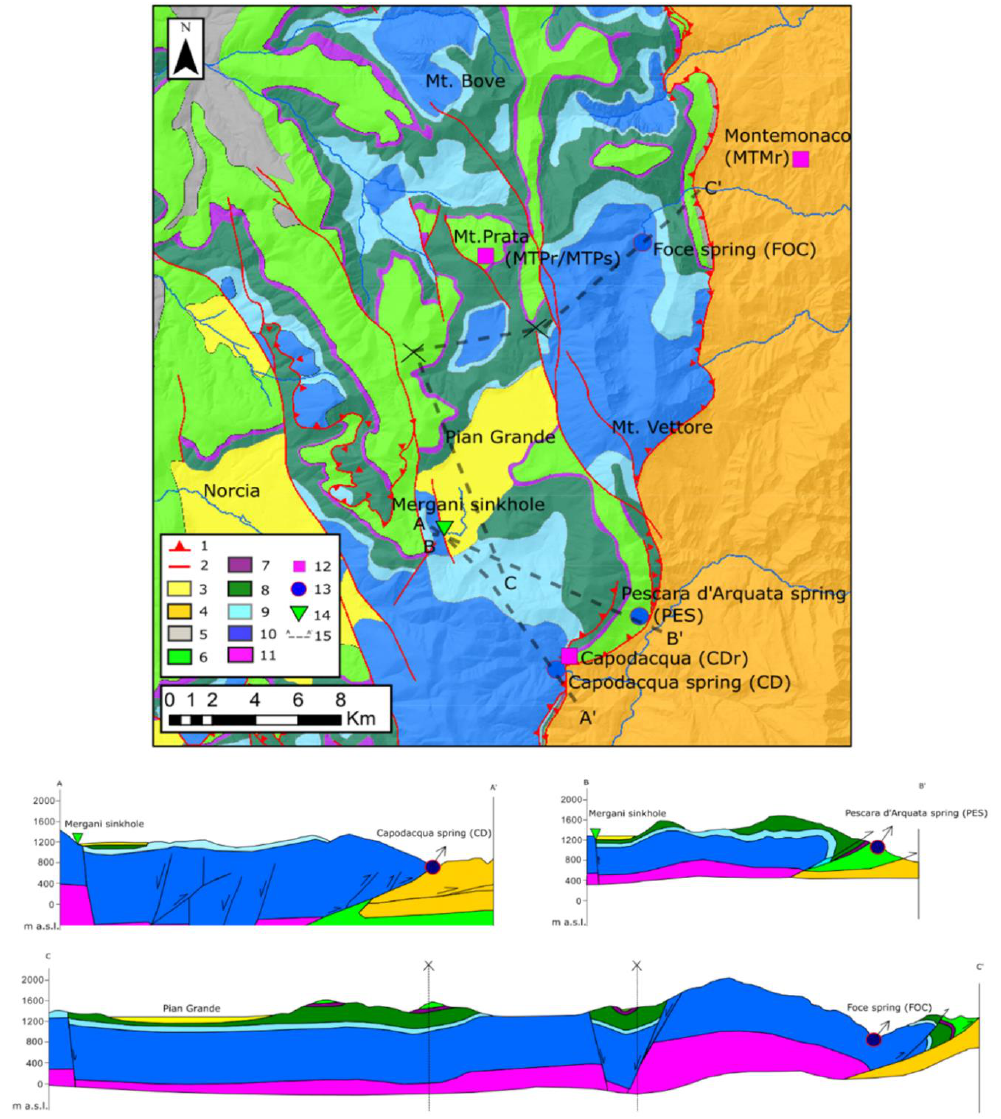
Figure 1. Hydrogeological sketch of the study area and location of the monitoring points. 1. Thrust fault; 2. Normal fault; 3. Alluvial and lacustrine deposits (Holocene-Pliocene); 4. Clay and sands units (Miocene); 5. Calcareous Marly units (Miocene-Eocene); 6. Scaglia Calcarea (Eocene-Cretaceous); 7. Marne a Fucoidi (Lower Cretaceous); 8. Maiolica (Lower Cretaceous-Jurassic); 9. Calcareous siliceous marly units (Upper Jurassic); 10. Corniola-Calcare Massiccio (Lower Jurassic); 11. Anidriti di Burano (Triassic); 12. Rain gauges and snow thickness gauge (see Table 1); 13. Spring discharge station with fluorimetric probes; 14. Tracer injection point. 15. Hydrogeological section. All the cross-sections are modified from the literature [29,38].